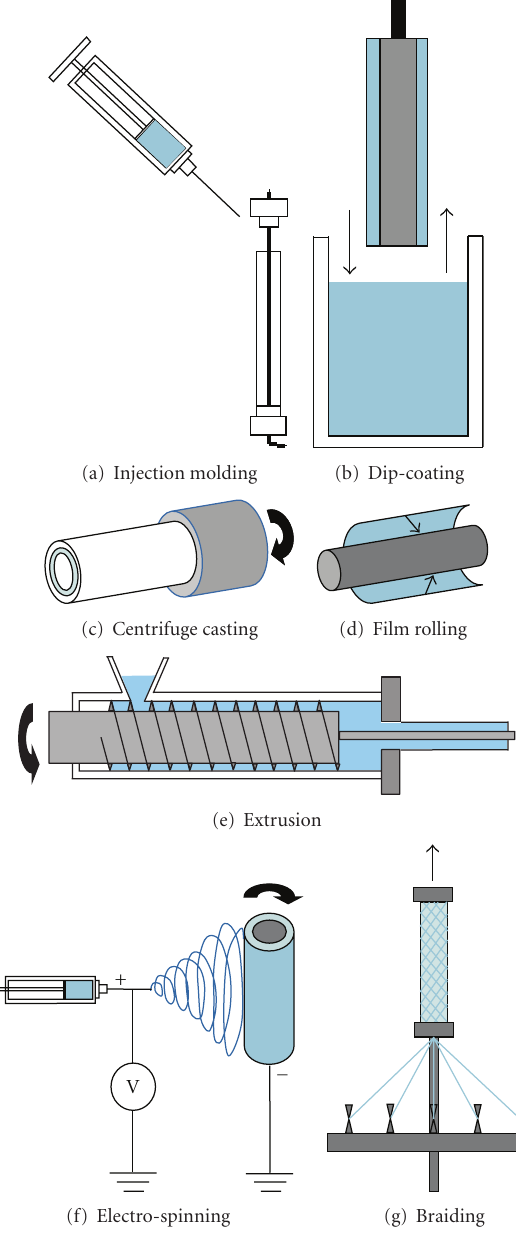
Figure 3: Widely used methods for fabricating polymer nerve